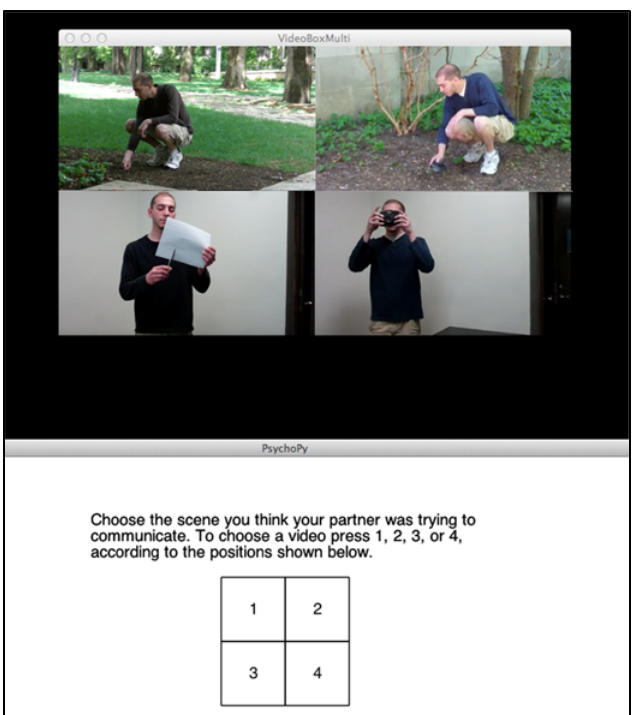
Figure 3. Example of a matching trial. The participant is shown a target and 3 foil videos playing in a loop on screen, and asked to select the video they think their partner was trying to communicate. The target and 3 foils were presented as a grid of 4 looping videos. The matcher made their guess by pressing the number (from 1–4) of the corresponding video, as indicated in a dummy grid presented below the videos (see Figure 3). Once the matcher